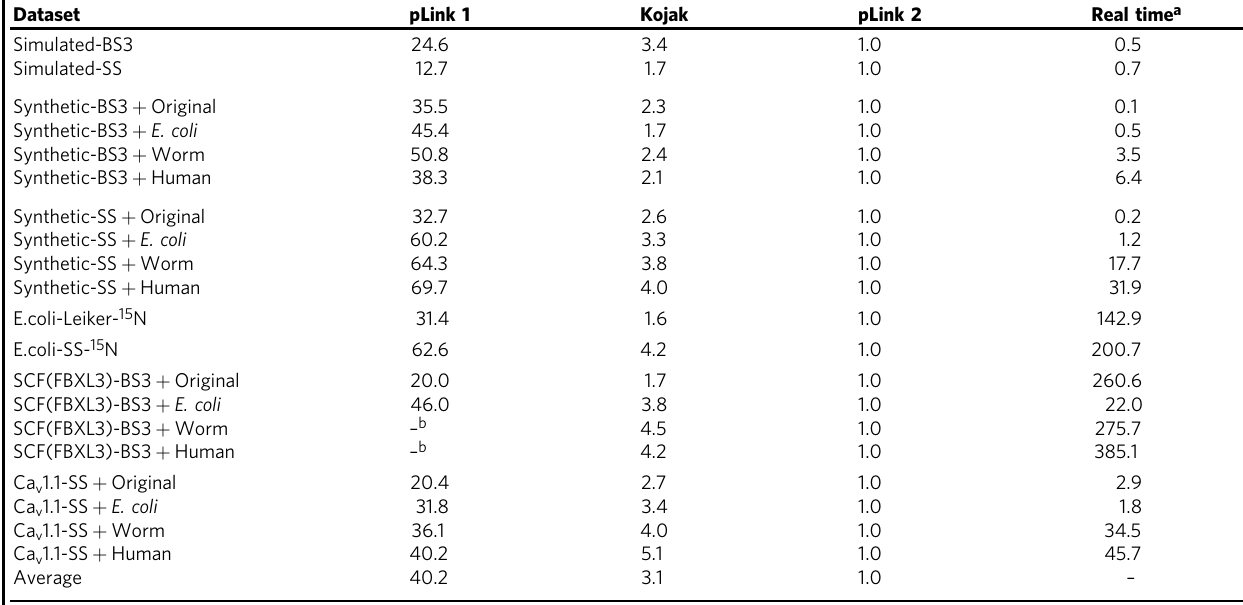
Table 2 The normalized computing times of the three search engines on eight datasets Dataset